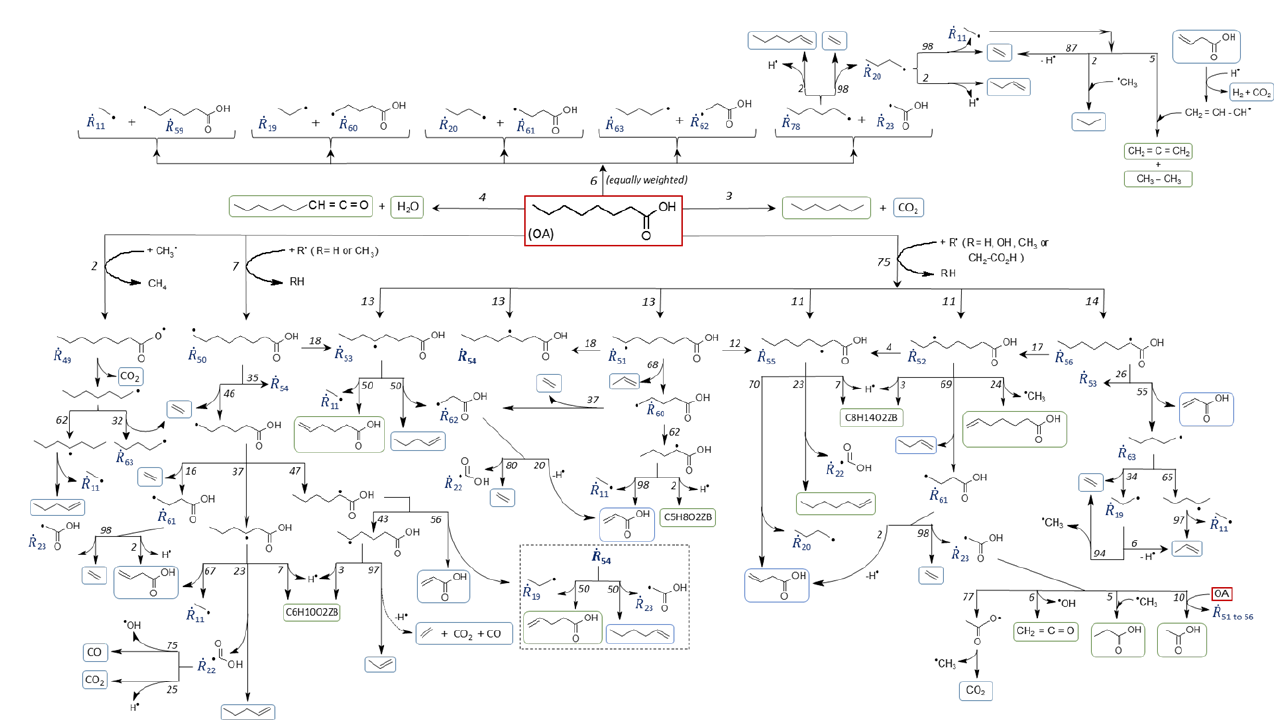
Figure 6. Overall scheme of octanoic acid (OA) pyrolysis as proposed in a previous work [13] on the basis of the experiments generated from the bench-scale setup detailed in this work (operating conditions of pyrolysis: 1 atm, 5% molar OA in N 2 , 421 ms residence time, oven set point temperature of 800 °C, tubular reactor axial coordinate 22 cm where temperature is 814 °C). Italic numbers indicate percent of parent species being converted to daughter species. C5H8O2ZB, C6H10O2ZB and C8H14O2ZB are globalized species considering isomers from which the major forms are, respectively: CH 2 =CH-CH 2 -CH 2 -COOH, CH 2 =CH-(CH 2 ) 3 -COOH, and CH 2 =CH-(CH 2 ) 3 -COOH.